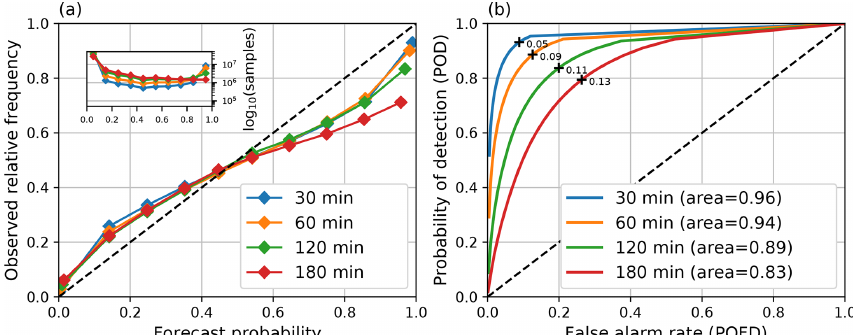
Figure 5. Reliability diagrams (a) and ROC curves (b) computed from STEPS nowcasts during the MeteoSwiss events listed in Table 8 with different lead times and threshold 0.1mmh − 1 . The default settings listed in Table 5 were used for computing the nowcasts. The optimal probability thresholds that maximize POD-POFD are marked in the ROC curves with black crosses.